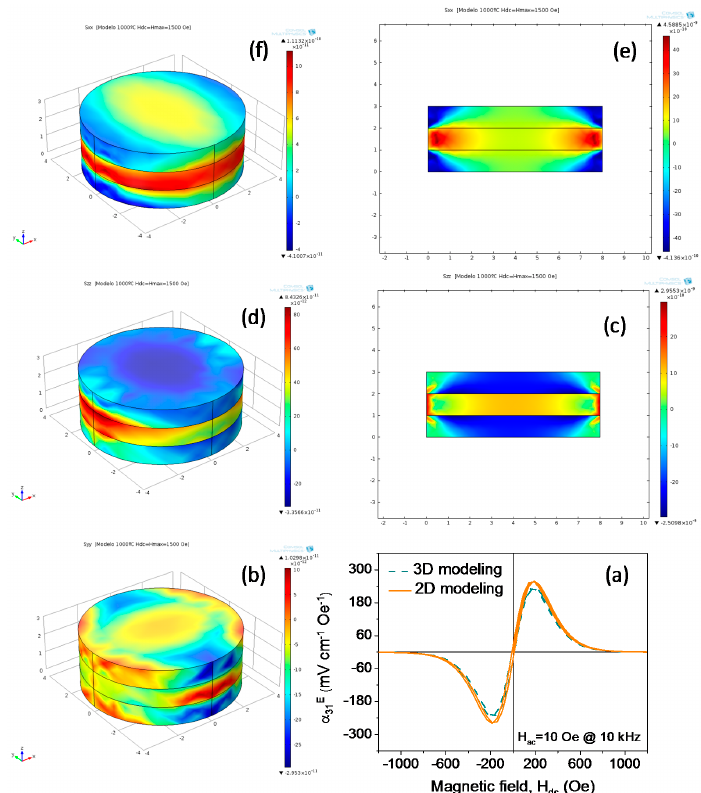
Figure 1. ( a ) Comparison of the magnetoelectric coefficient α 31 E obtained by simulation of a Bi 0.36 Pb 0.64 Sc 0.36 Ti 0.64 O 3 /NiFe 2 O 4 /Bi 0.36 Pb 0.64 Sc 0.36 Ti 0.64 O 3 1 mm/1 mm/1 mm three-layer structure with 8 mm in-plane dimension using 3D and 2D models. Strain fields for both cases are given: ( b ) S 22 3D; ( c ) S 33 2D; ( d ) S 33 3D; ( e ) S 11 2D; and ( f ) S 11 3D. Material coefficients corresponding to processing at 1000 ◦ C have been